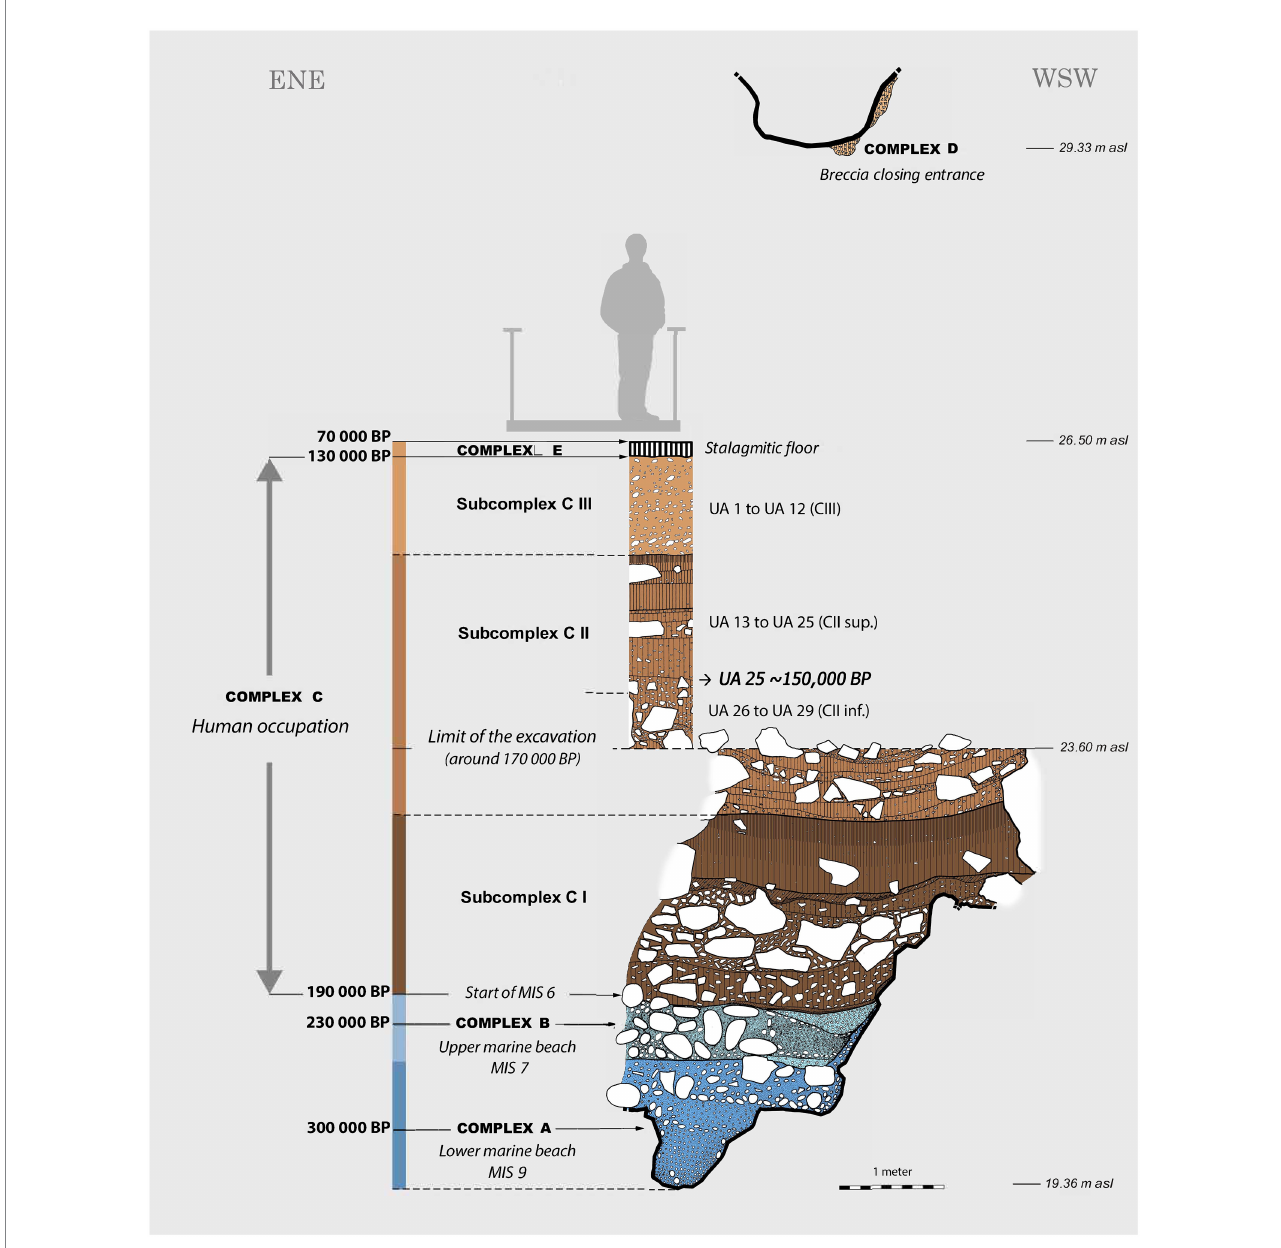
FIGURE 2 Profile of Lazaret Cave from excavations prior to 2015. Image adapted from Michel et al.